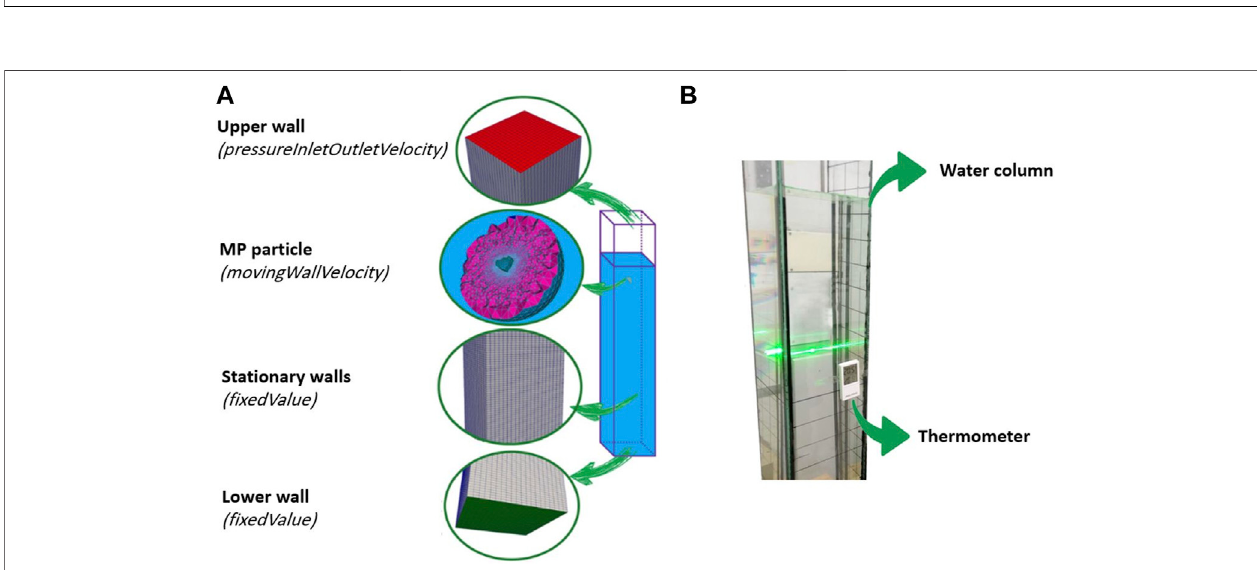
FIGURE 2 | (A) Schematic of the whole simulation setup and the assigned velocity boundary conditions to each sub mesh set. (B) Water column used in the laboratory experiments including glass water container, and thermometer to check the temperature of water in the column.